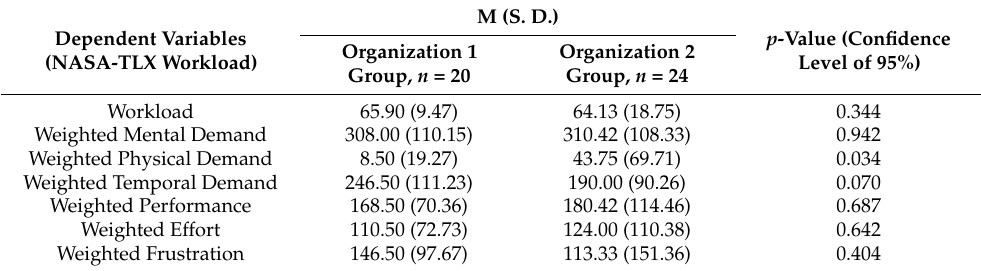
Table 2. Averages of the perceived workload measures and the result of the significance test.